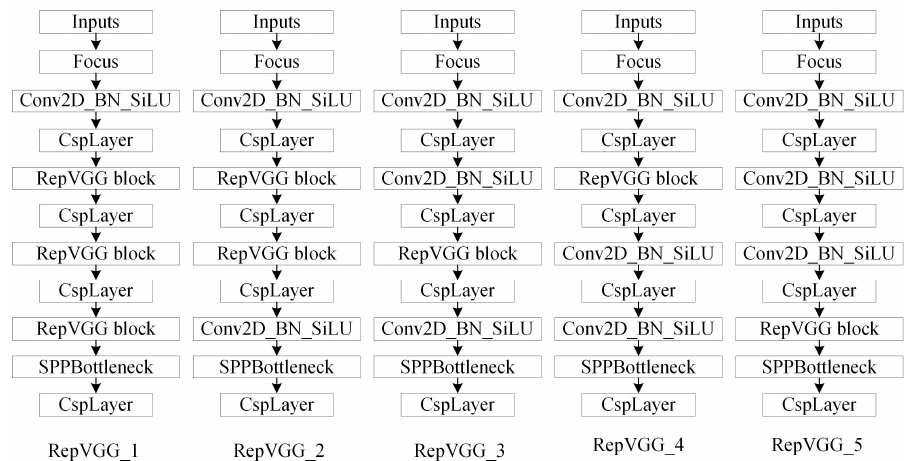
Figure 8. The RepVGG block of backbone is added at different locations. Table 1. Experimental results of RepVGG at different locations. P stands for precision rate, R stands for recall rate, FPS stands for frame per second, and mAP stands for mean average precision. Location P/(%) R/(%) RepVGG_1(Relu)